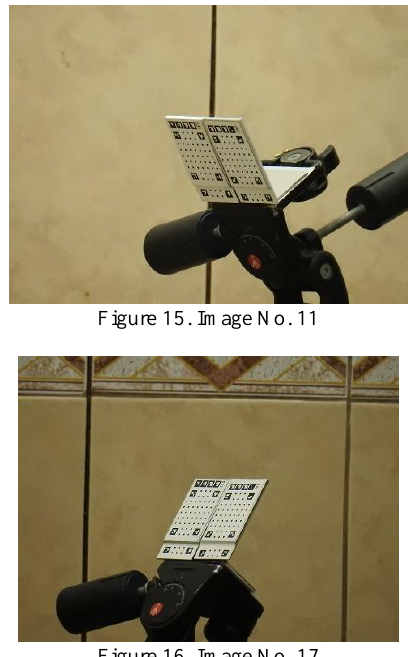
Figure 16. Image No. 17